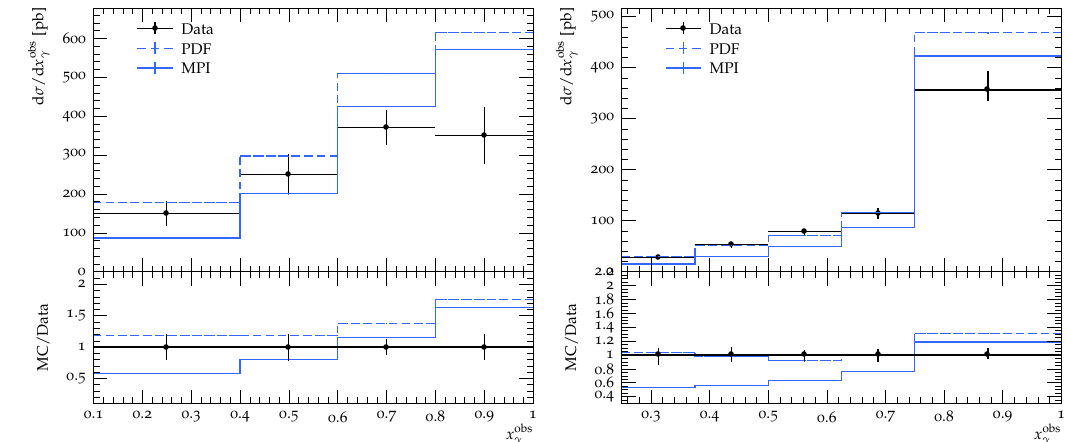
Figure 2: Differential cross sections in terms of x obs the MPI rejection compared to H1 (left) and ZEUS (right)